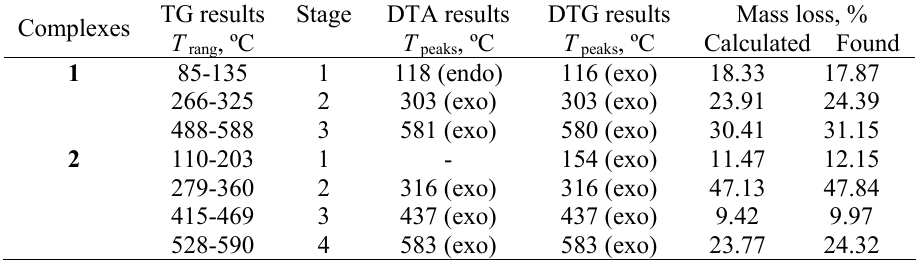
Table 2. Phenomenological data for the thermal decomposition of the obtained complexes TG results Complexes T , rang